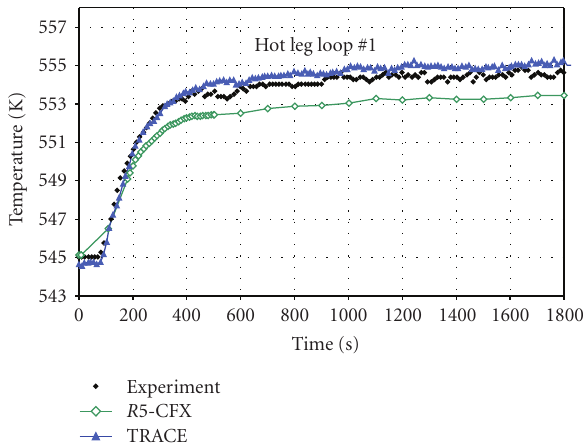
Figure 19: Comparison of the data with the predictions for loop 1.